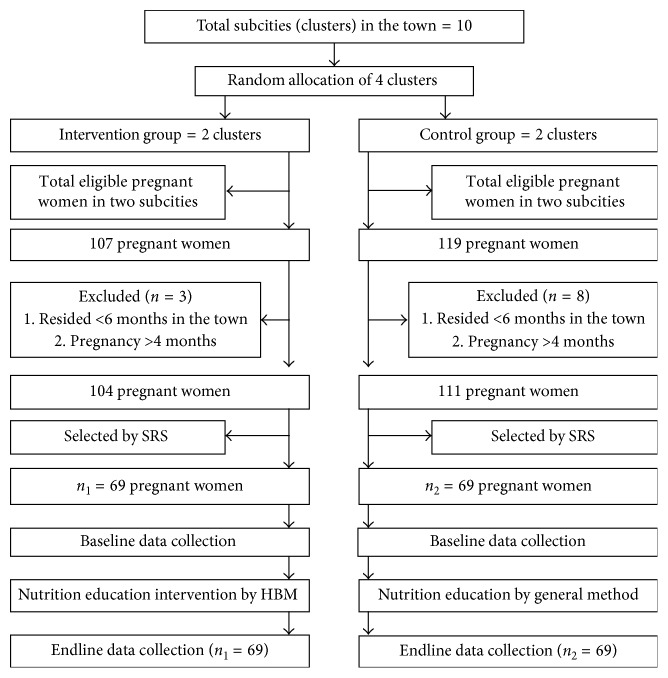
Sampling procedure of pregnant women. SRS = simple random sampling; n1 = sample size for intervention group; n2 = sample size for control group; HBM = Health Belief Model.